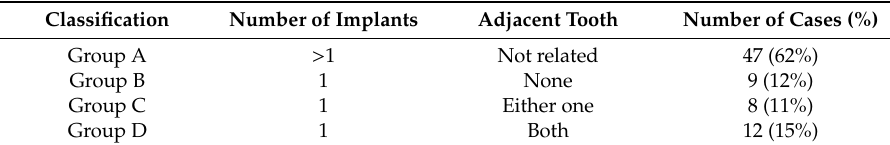
Table 1. Classification of maxillary sinus augmentation.